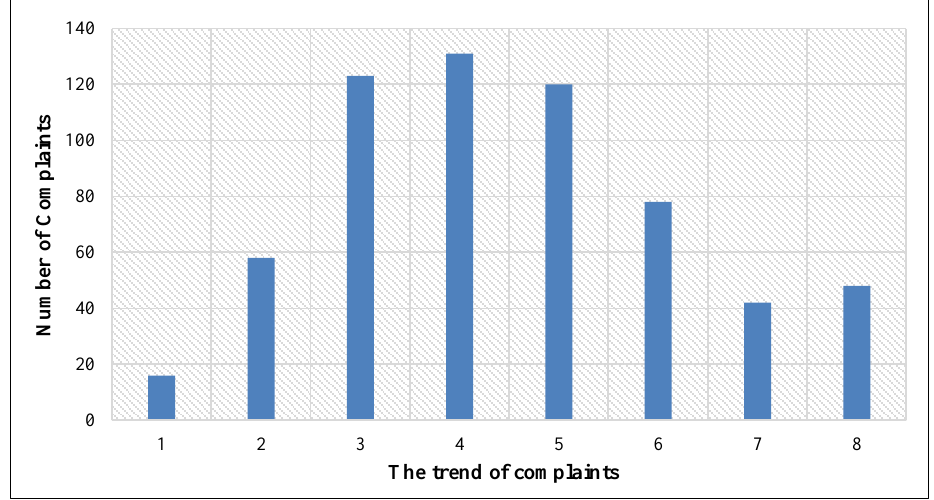
Figure 4. Graphical presentation of the trend of complaints by years in